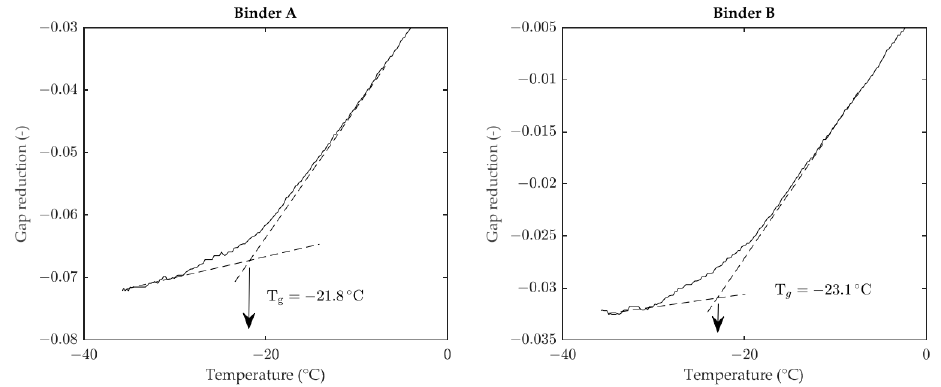
Figure 1. Determination of the glass transition temperature.